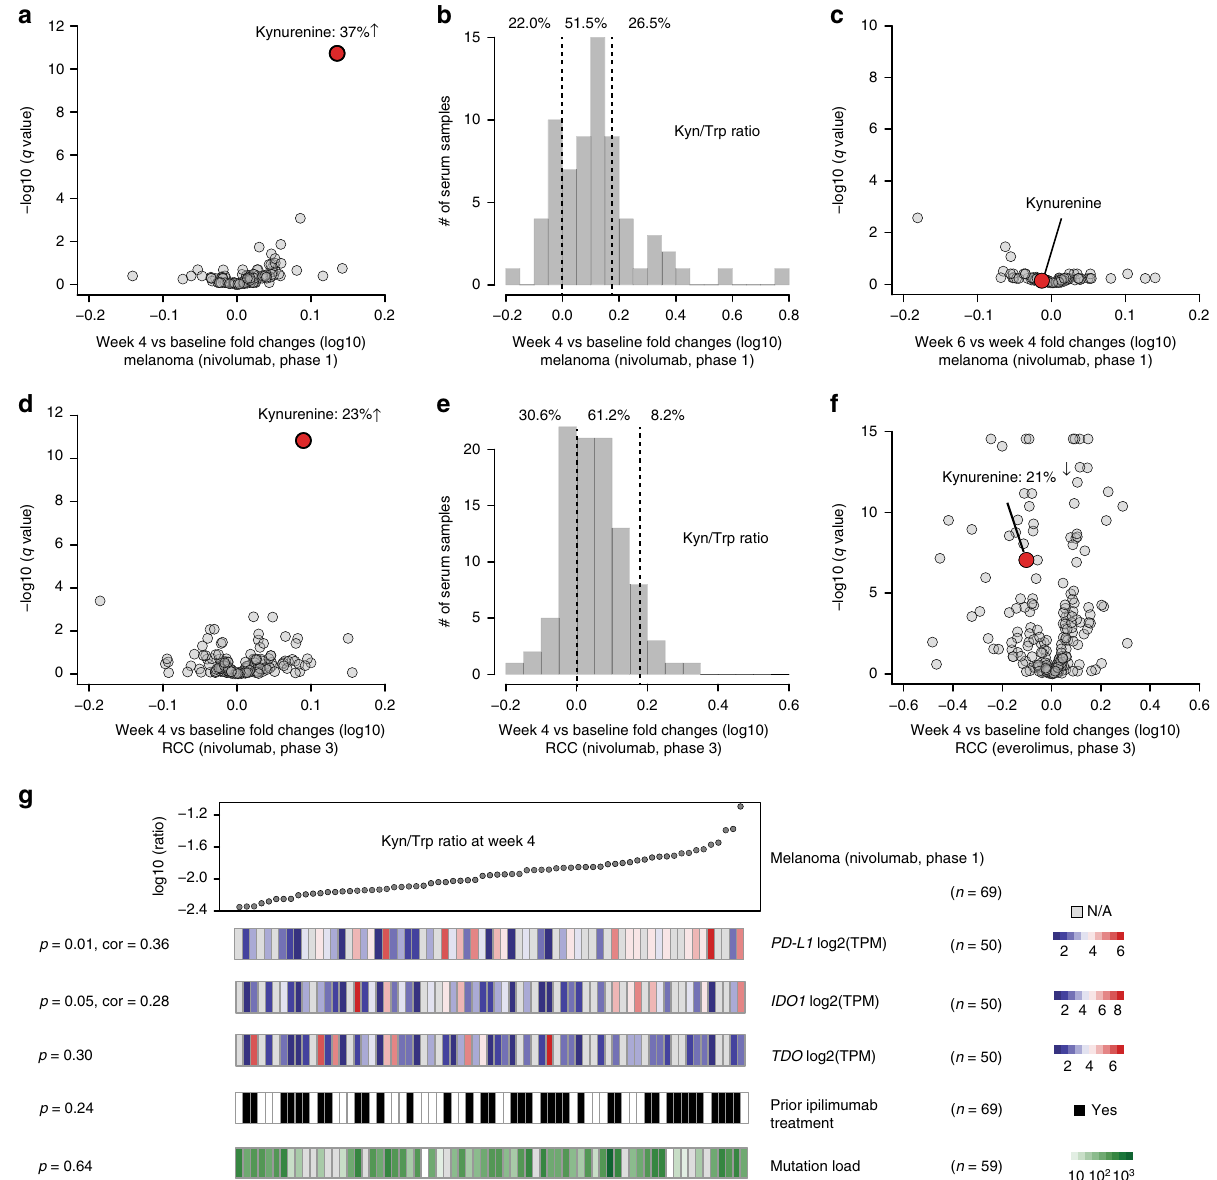
Fig. 2 Comprehensive serum metabolomic pro fi ling reveals signi fi cantly up-regulated kynurenine in response to nivolumab treatment. a Volcano plots showing average serum metabolite ( n = 106, represented as points) level changes after 4 weeks of nivolumab treatment compared to baseline in CA209- 038 melanoma patients. b Histogram showing the changes of kynurenine/tryptophan (Kyn/Trp) ratios 4 weeks after nivolumab treatment compared to baseline in melanoma patients. c Volcano plot showing average serum metabolite ( n = 106) changes between week 6 and week 4 after nivolumab treatment in melanoma patients. d Volcano plots showing average serum metabolite ( n = 202) level changes after 4 weeks of nivolumab treatment compared to baseline in CheckMate 025 RCC patients. e Histogram showing the changes of Kyn/Trp ratios 4 weeks after nivolumab treatment compared to baseline in CheckMate 025 RCC patients. f Volcano plot showing average serum metabolite ( n = 202) level changes after 4 weeks of everolimus treatment compared to baseline in CheckMate 025 RCC patients. g Pearson correlation analysis between Kyn/Trp ratios and PD-L1 / IDO1 / TDO mRNA expression at week 4, prior anti-CTLA4 treatment (ipilimumab), and tumor mutation load in melanoma patients. The q values in a , c , d , f were calculated based on paired t -tests for all pro fi led metabolites with Benjamini-Hochberg multiple testing